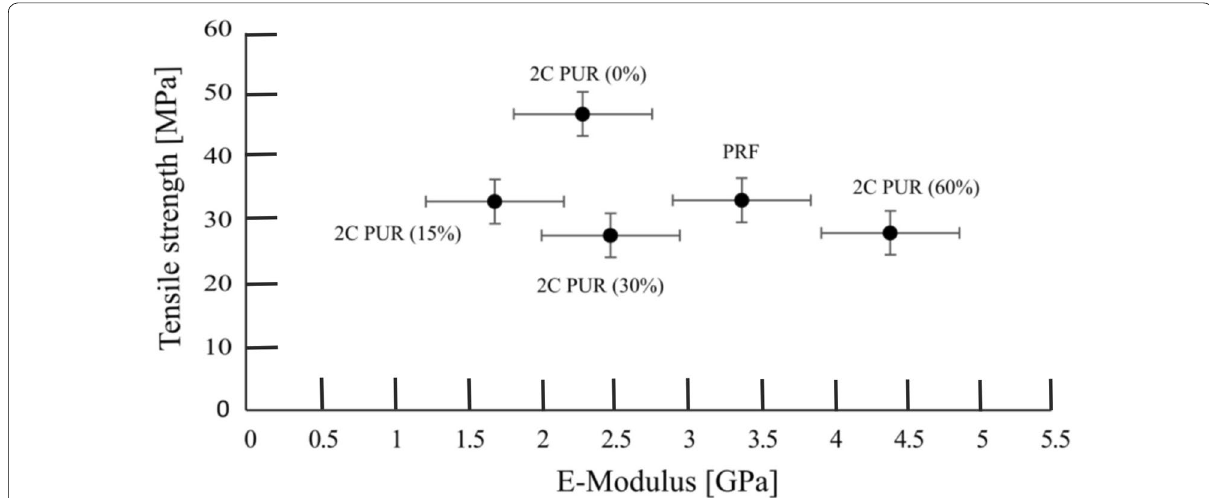
Fig. 3 Tensile strength and E-Modulus of adhesive films in standard climate ( n shown in